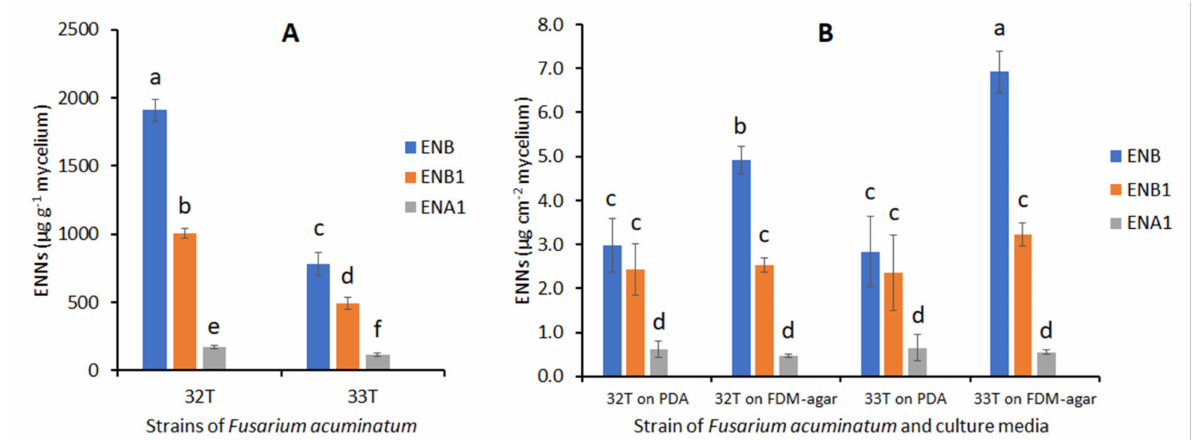
Figure 4. Accumulation of enniatins by F. acuminatum 32T and 33T in different culture media measured after 11 days of culture at 25 ◦ C. ( A ) = culture in FDM liquid medium, ( B ) = culture on PDA and FDM-agar medium. Values are means of triplicates. Error bars are ± standard deviation. Means with the same lowercase letter are not significantly different ( p <